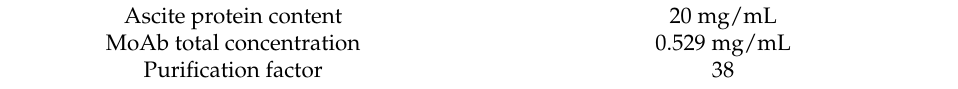
Table 2. Protein content of the ascite and final purification factor of MoAbs.